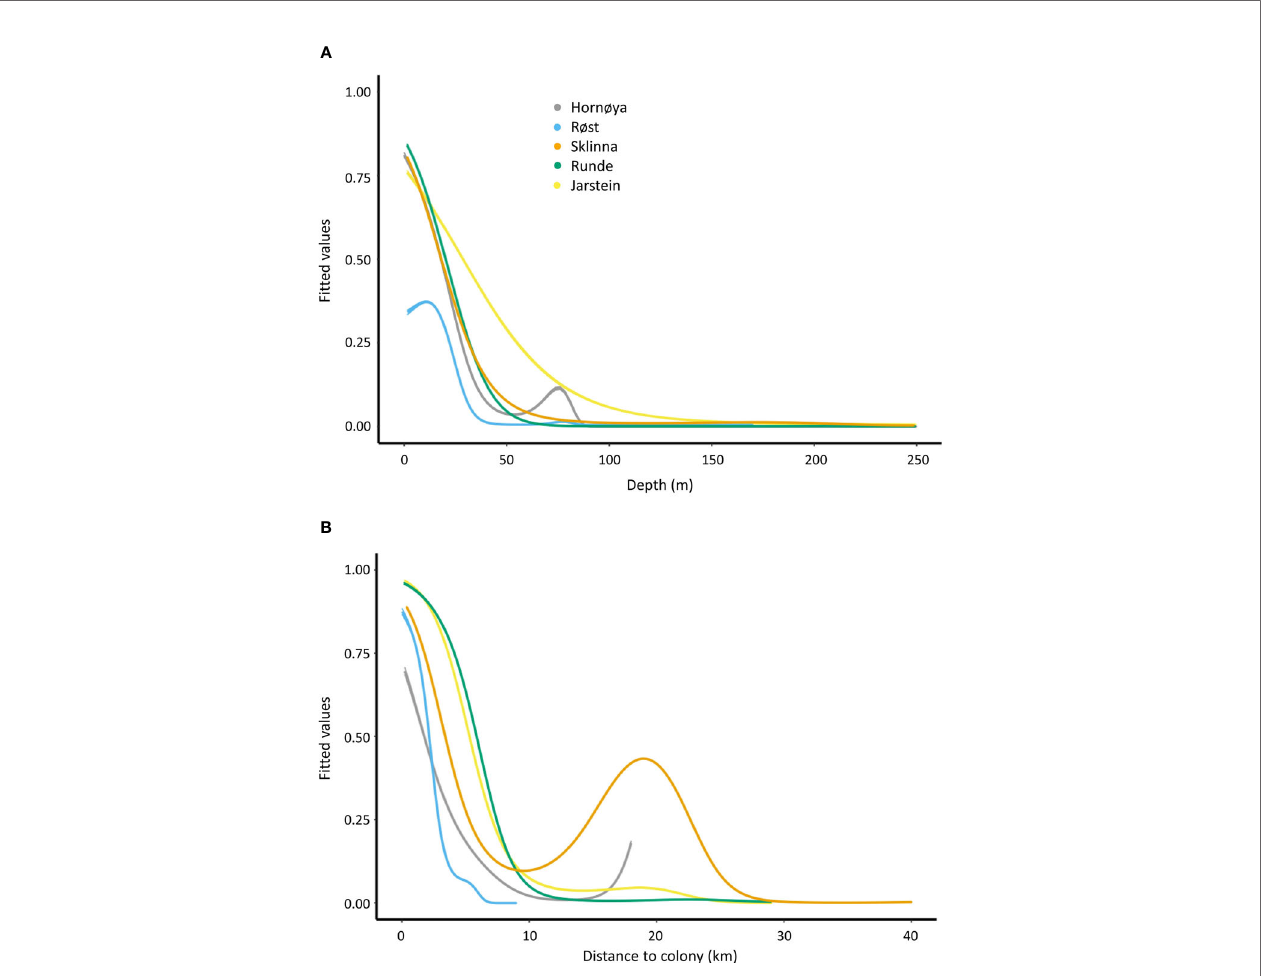
FIGURE 3 | Model response curves ( fi tted values ± SE) showing the predicted foraging probability in response to depth (A) and distance from colony (B) for the different colonies. Fitted values were extracted from the individual models per colony (e.g. for the Hornøya colony model HM3 and HM5; see Table 3